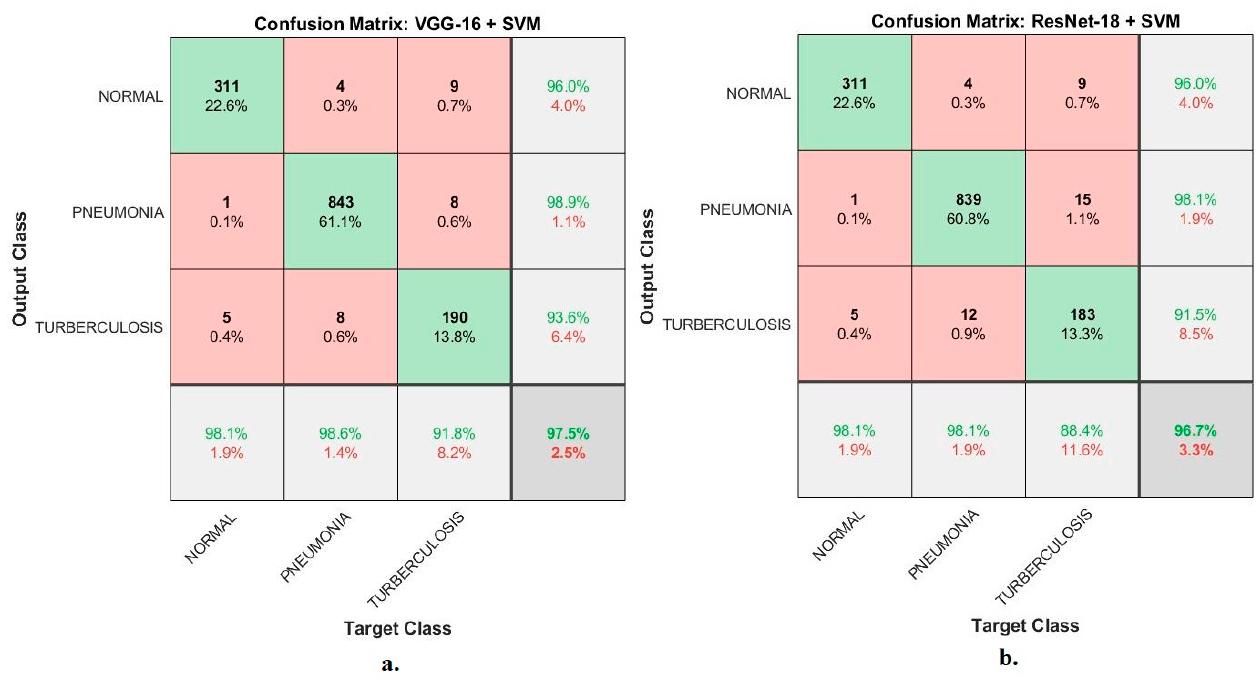
Figure 7. The performance of the hybrid methods for diagnosing the X ‐ rays of the pneumonia and tuberculosis data set.